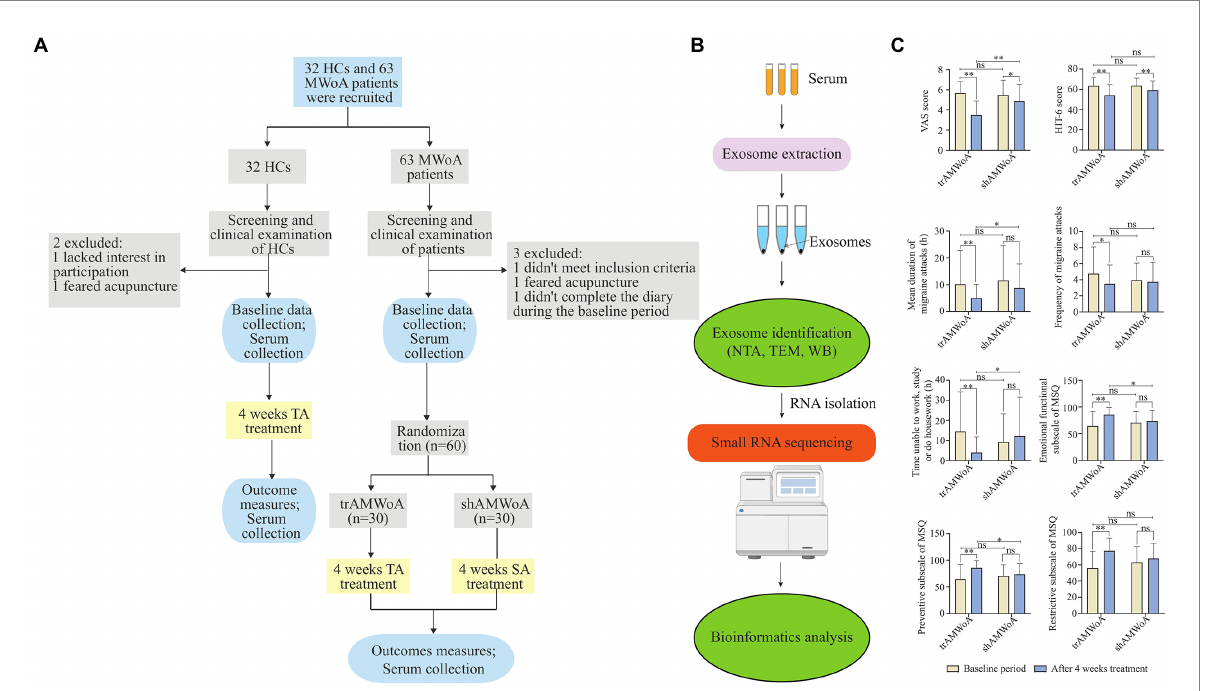
FIGURE 1 Study outline, sample workflow and clinical outcomes before and after 4-week treatment. (A) The detailed process of screening, enrollment, randomization, and treatment. (B) Workflow from sample collection to exosome identification, small RNA sequencing and bioinformatics analysis. (C) Clinical outcomes of trAMWoA and shAMWoA in baseline and after 4-week treatment. * represents p < 0.05, ** represents p < 0.01. HCs, healthy controls; trAMWoA, migraine without aura patients receiving true acupuncture treatment; shAMWoA, migraine without aura patients receiving sham acupuncture treatment; TA, true acupuncture; SA, sham acupuncture; NTA, nanoparticle tracking analysis; TEM, transmission electron microscopy; WB, western blotting; VAS, visual analogue scale; Headache Impact Test-6 scale, HIT-6; MSQ, migraine-specific quality of life questionnaire; MWoA, migraine without